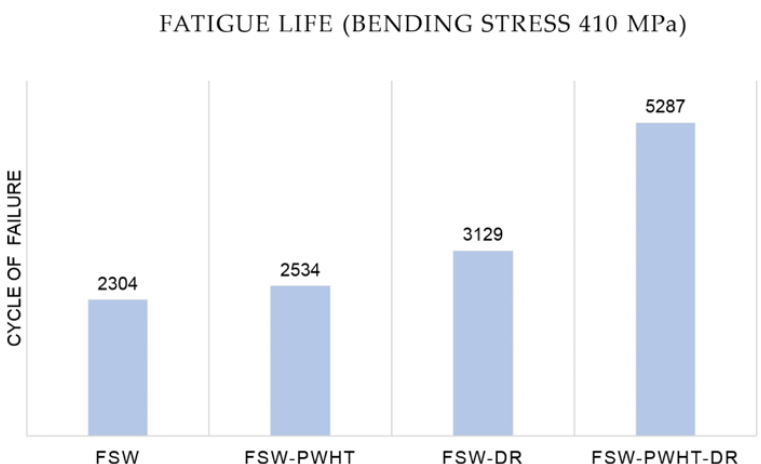
Figure 22. Fatigue life of the workpieces. Table 10. Comparison of the fatigue life of the workpieces.